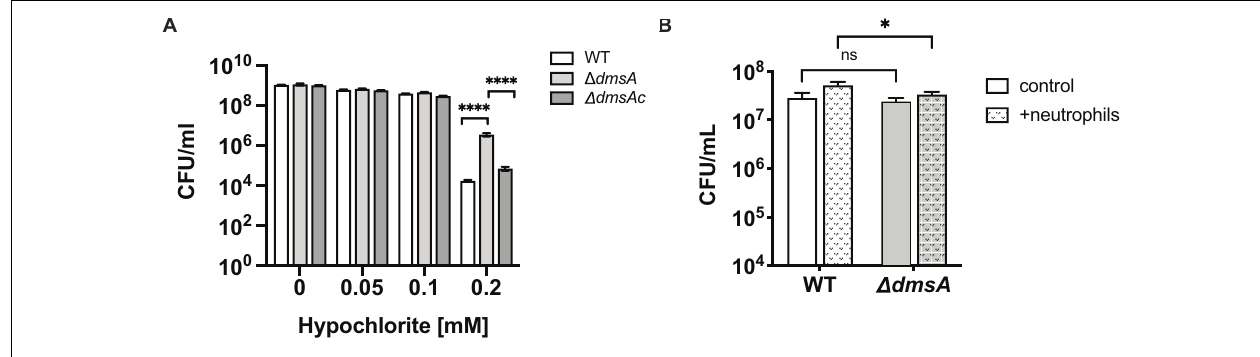
FIGURE 4 | Sensitivity of Hi2019 (cid:49) dmsA to hypochlorite-induced stress. (A) survival of Hi2019 WT Hi2019 (cid:49) dmsA and Hi2019 (cid:49) dmsAc in the presence of increasing concentrations of hypochlorite. Bacteria were suspended in 1 × PBS prior to exposure to HOCl for 60 min. (B) Survival of Hi2019 WT and Hi2019 (cid:49) dmsA following exposure to human primary neutrophils for 30 min. Statistical testing for Panel (A) data used one-way ANOVA ( post hoc test: Tukey–Kramer), and two-way ANOVA ( post hoc test: Bonferroni) for data in Panel (B) ; ∗∗∗∗ p < 0.0001, ∗ p < 0.05, ns – not significant.